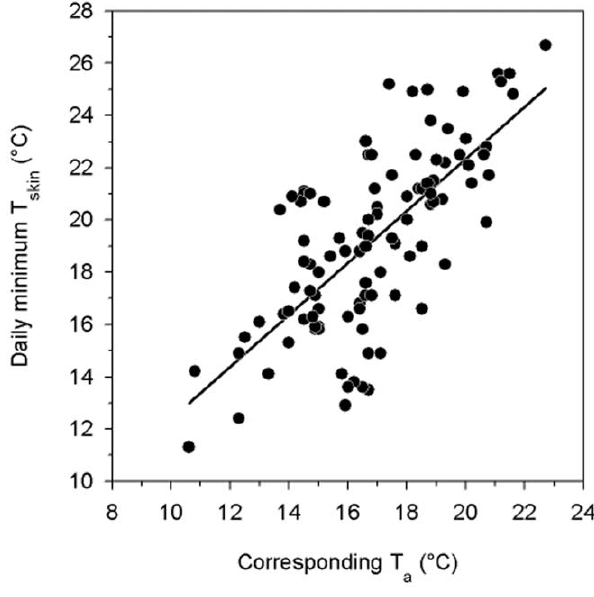
longest torpor bouts recorded for each individual were strongly affected by minimum T a (R 2 = 0.8, P , 0.001; Fig. 2) and the thermal response for this relationship was pronounced (Q 10 =10).